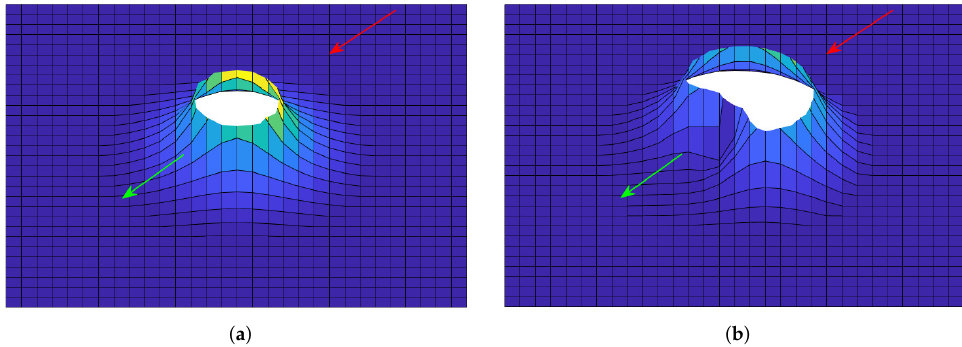
Figure 3. Comparison between APF and ADPF for a repulsive potential field. ( a ) APF, ( b )